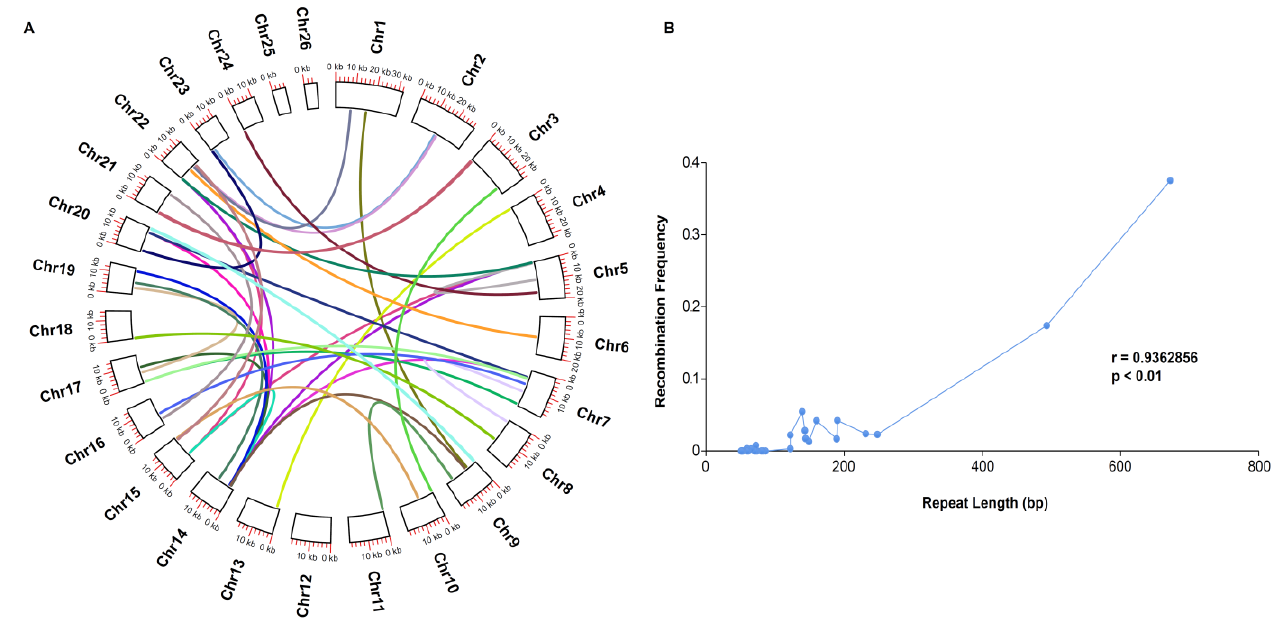
Figure 4. Recombination frequency in the mitogenome of Paphiopedilum micranthum . ( A ) The distri- bution of the 34 pairs of repeats; ( B ) recombination frequency of 34 pairs of repeats (>50 bp) with 100% identity.